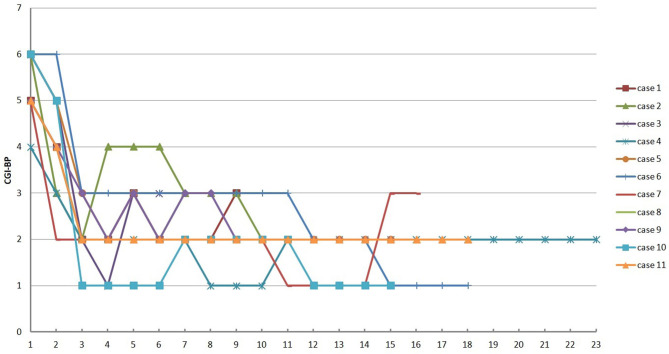
The distribution of CGI-BP of all the participants over each injection of PP1M.